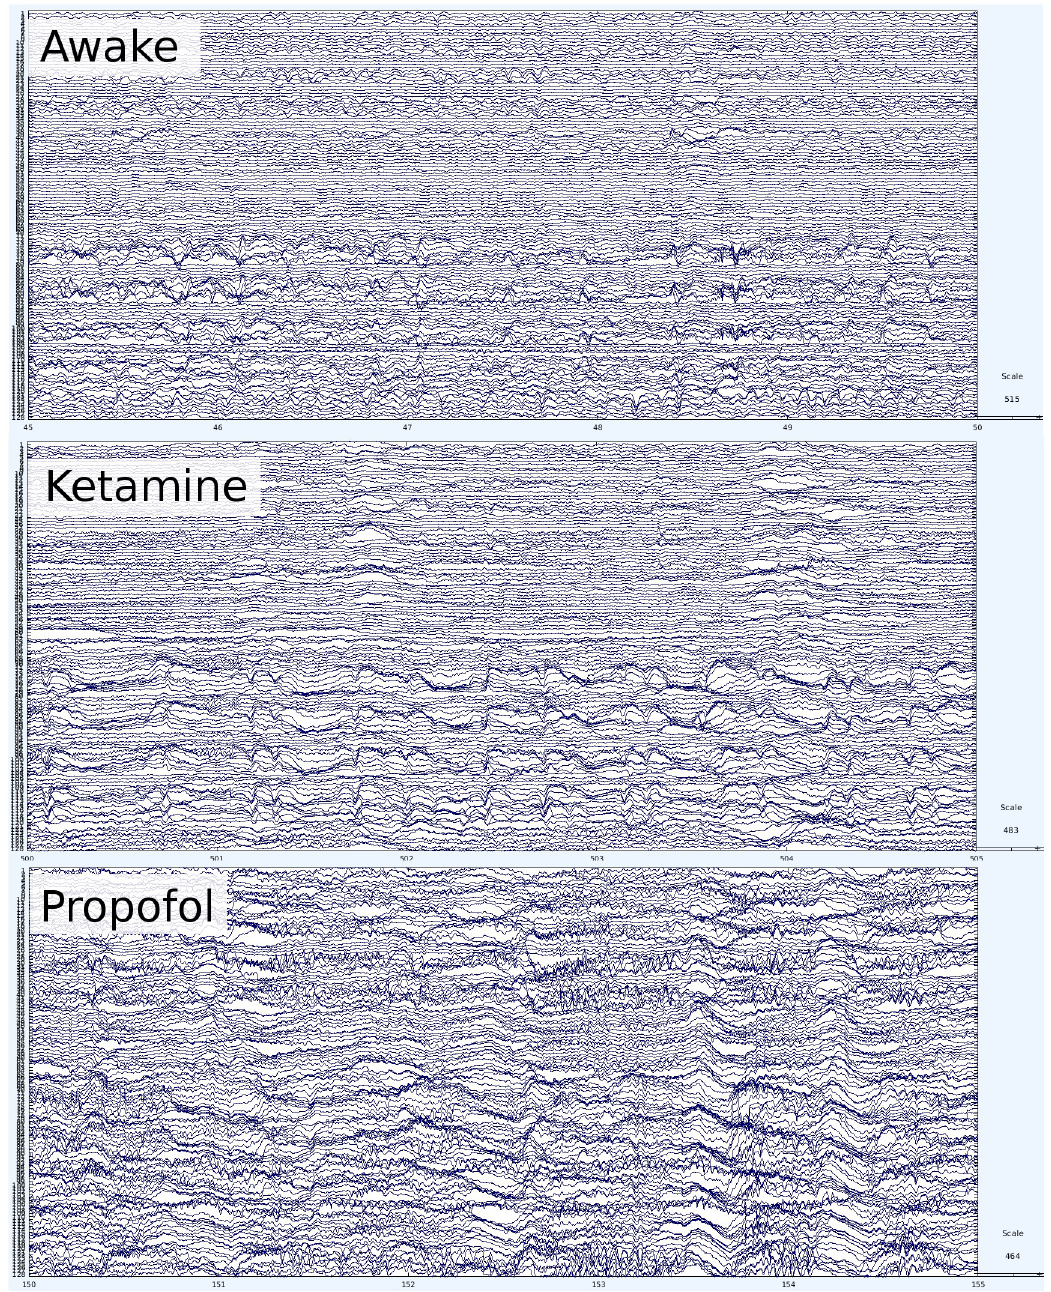
Fig 3. Best-fit normal distributions between conditions. Representative examples of the histograms of instantaneous amplitudes across the three conditions. A : the awake condition. B : ketamine, and C : propofol. Note that while ketamine allows for a heavy-tail to persist, the propofol condition collapses to a tight Gaussian